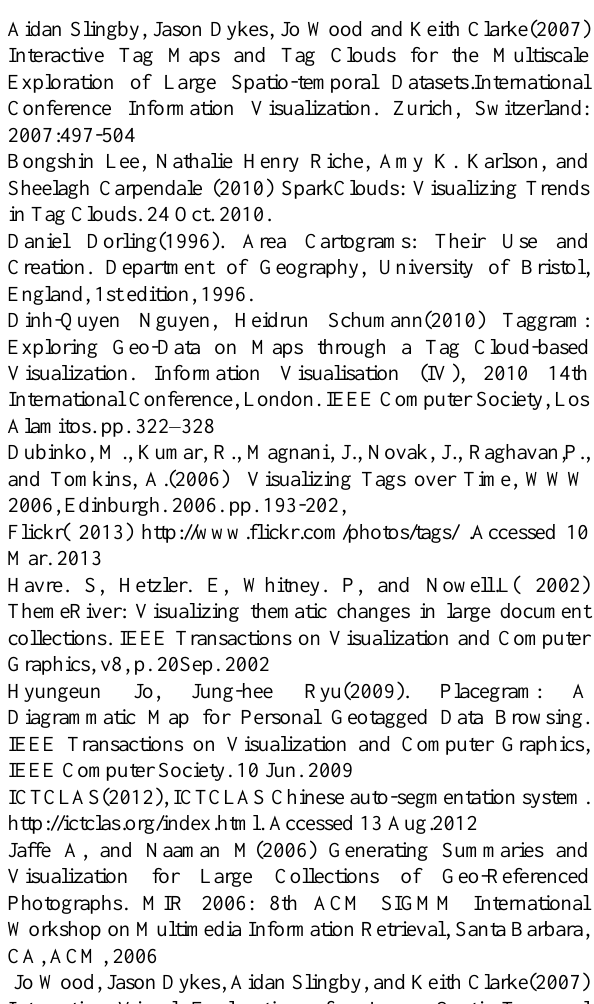
Figure 12. A polyline appears under text to represent it’s frequency of recent days